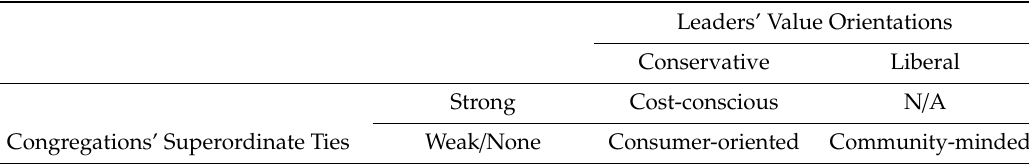
Table 1. Congregations’ Organizational